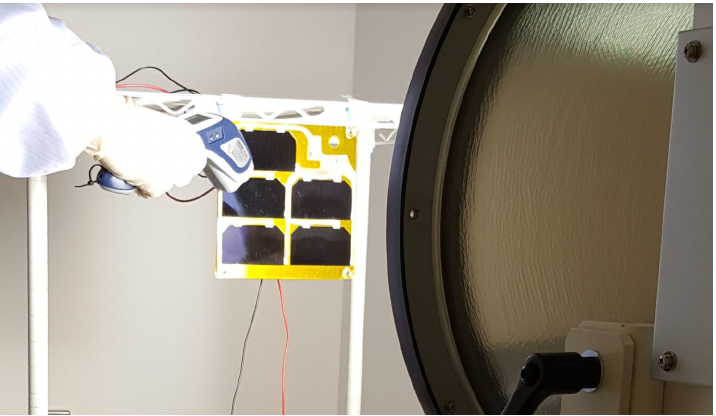
Figure 11. SMIC in the sun